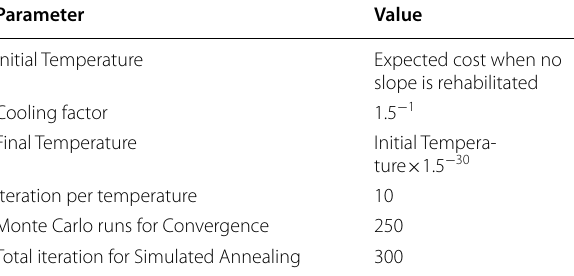
Table 2 Parameters for risk-averse simulated